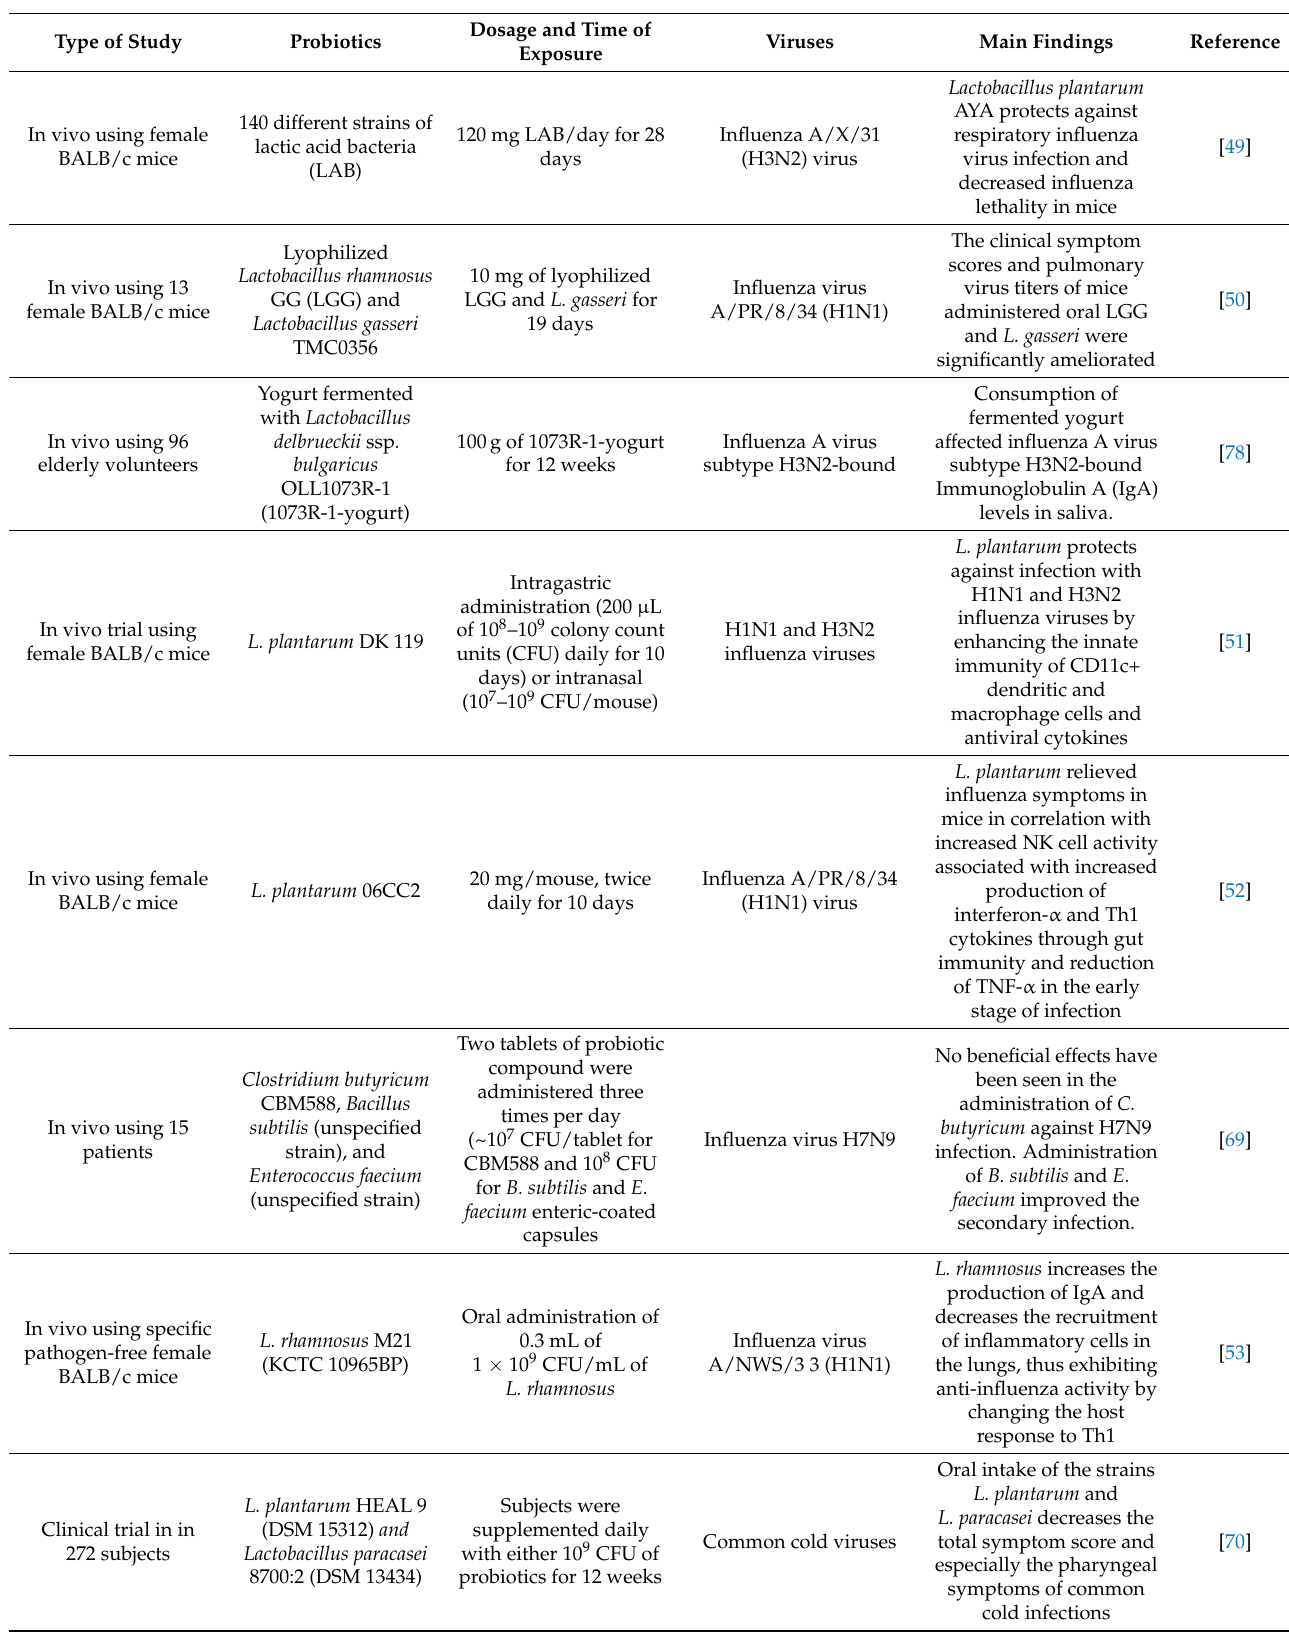
Table 1. Effects of probiotics against respiratory